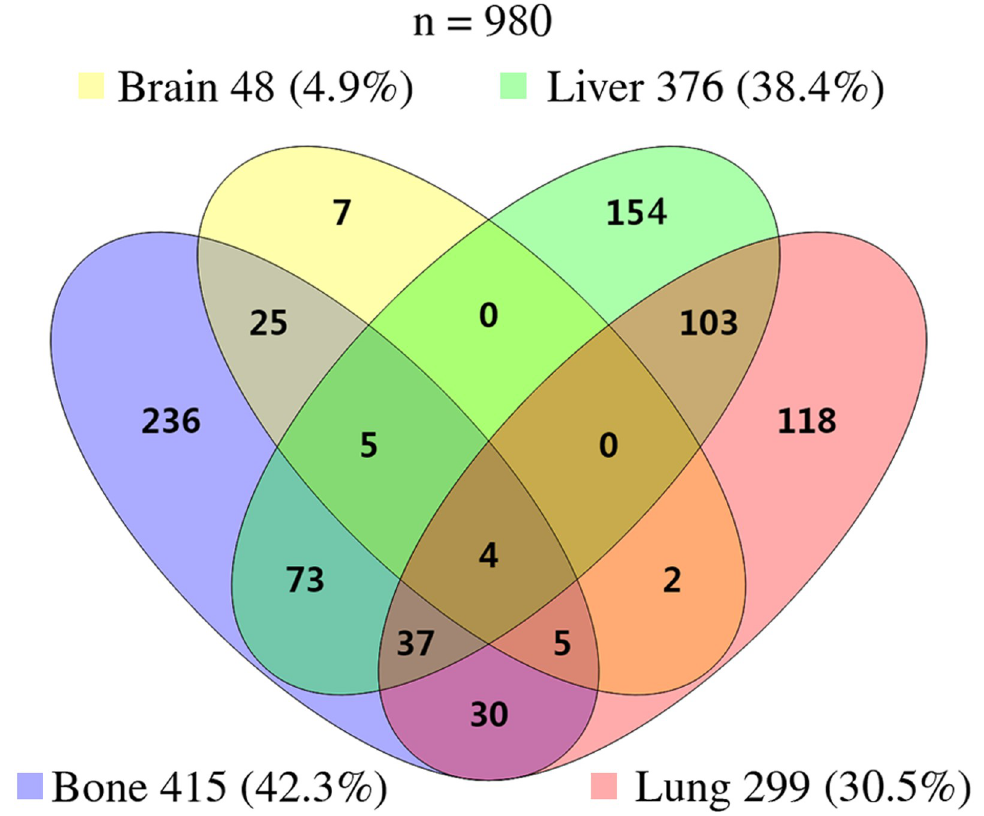
Fig 1. Venn diagram of the distribution of distant metastatic sites. There were four types of metastatic sites in 980 patients. Bone metastasis was the most common forms of metastasis.